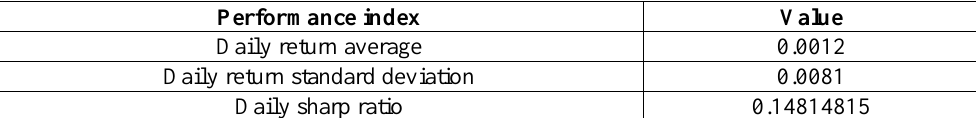
Table 8. statistical description of market